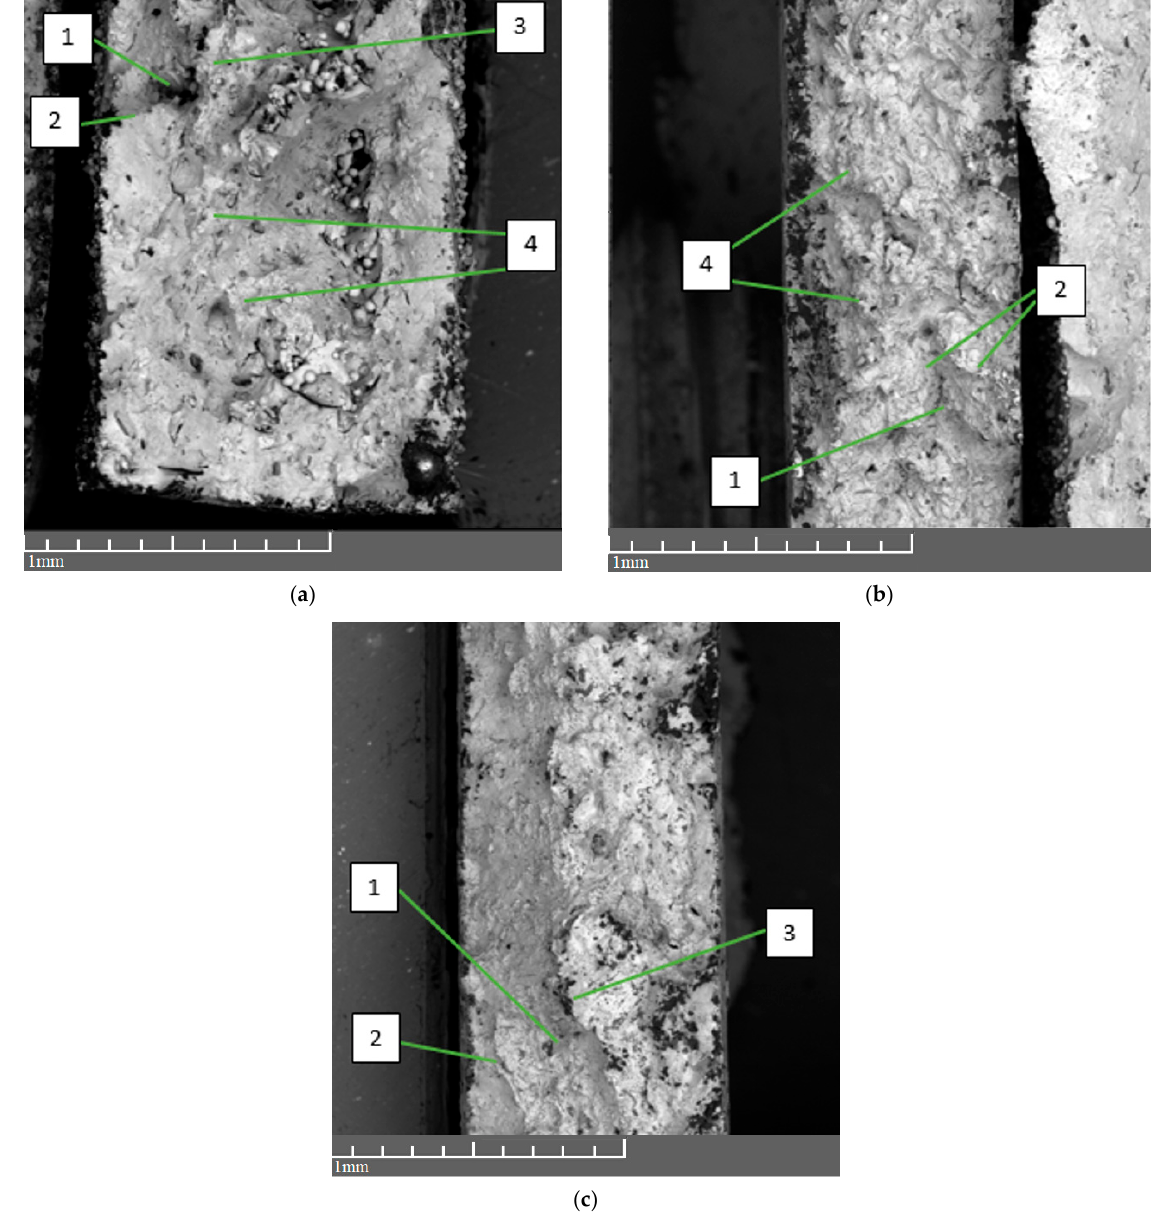
Figure 8. SEM images of the experimental samples: ( a )—sample without thermal treatment; ( b )—sample after type 1 thermal treatment type; ( c )—sample after type 2 thermal treatment) (1—dimples, 2—sharp edges, 3—flat ridges, 4—gradual ridges).